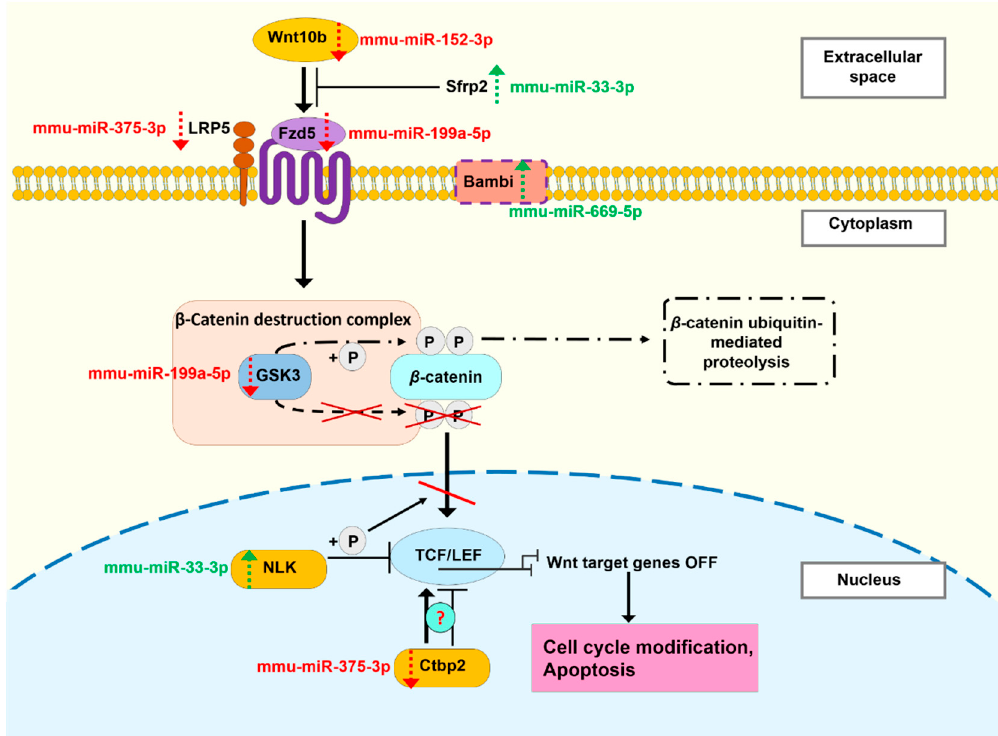
Figure 12. The Influence of Differentially Expressed miRNAs on the Wnt Pathway. The Wnt signal transduction pathway is an evolutionary conserved pathway regulating basic developmental pro- cesses such as progenitor cell proliferation and cell-fate specification [63], and it can be downregulated upon exposure to ionizing radiation [64,65]. The transcription of Wnt-related genes can be regulated by the cytoplasmic concentration of the β -catenin intracellular signal transducer. Without Wnt ligand binding to its receptor Frizzeld [66] and co-receptor low-density lipoprotein receptor related 5/6 (LRP5/6) [67–69], β -catenin is degraded by a destruction complex, which contains axin, adenomato- sus polyposis coli (APC), protein phosphatase 2A (PP2A), and two kinases, glycogen synthase kinase 3 (GSK3) and casein kinase 1 α (CK1 α ). In the β -catenin destruction complex, GSK3 and CK1 α phosphorylate β -catenin, leading to its proteosomal degradation [70]. Upon Wnt ligand binding, the destruction complex is disrupted, and β -catenin is enriched in the cytoplasm, which leads to its nuclear transport. In the nucleus β -catenin binds to lymphoid enhancer-binding factor/T-cell factor (LEF/TCF) proteins, transforming it into a transcriptional activator, leading to the transcription of Wnt target genes [71–74]. In the absence of β -catenin, LEF/TCF block the transcription of Wnt target genes [75,76]. The Wnt pathway was targeted by multiple differentially expressed miRNAs in the extracellular vesicles. Targets were associated with miRNAs by Diana mirPath v.3. We present our hypothesis of how differentially expressed miRNAs in 2Gy extracellular vesicles isolated from the bone marrow of mice 24 h after irradiation lead to the repression of the Wnt pathway. MiRNAs mostly repress the expression of their targets, so Wnt components targeted by upregulated miRNAs (illustrated in red in the Figure) are supposed to be downregulated, and components targeted by downregulated miRNAs (illustrated in green in the Figure) are supposed to be upregulated, com- pared to 0Gy samples. Arrows indicate the possible changes in the expression of the proteins targeted by the differentially expressed miRNAs: a red down arrow indicates decreased expression upon miRNA interaction, and a green up arrow indicates increased target expression. Mmu-miR-33-3p, a down-regulated miRNA targets a secreted frizzled-related protein 2 (Sfrp2), which is a Wnt antago- nist [77,78], and nemo-like kinase (NLK), which is an inactivator of β -catenin TCF/LEF transcription complex formation [79]. The other downregulated miRNA mmu-miR-669o-5p interacts with the BMP and Activin Membrane Bound Inhibitor (Bambi) which can both up- and downregulate the β